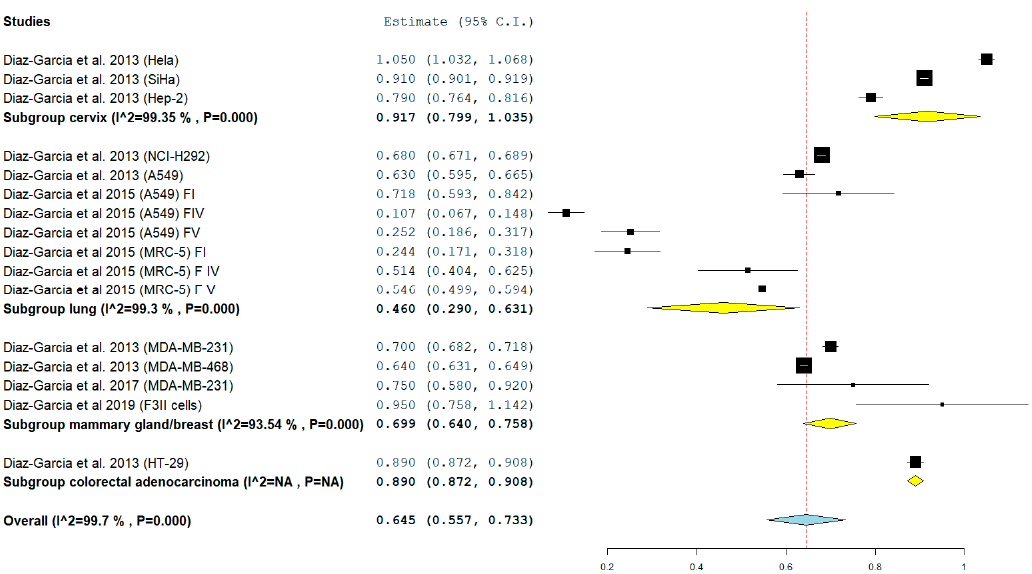
Figure 3. Forest plot of the 4 Subgroups. Subgroup Cervix: IC 50 0.917 mg/mL (Hela, SiHa, Hep-2); Subgroup Lung: IC 50 0.460 mg/mL (NCI-H292, A549, MRC-5); Subgroup mammary gland/breast: IC 50 0.699 mg/mL (MDA-MB-231, F3II, MDA-MB-468); Subgroup colorectal, adenocarcinoma: IC 50 mg/mL 0.890 (HT-29). The results of the meta-analysis for each subgroup are highlighted in bold. Yellow rhombuses in the forest plot indicate the average effect for each subgroup investigated, the red line shows the position of the average value and the rhombus in light blue shows the measure of the average effect. NA stands for not applicable .